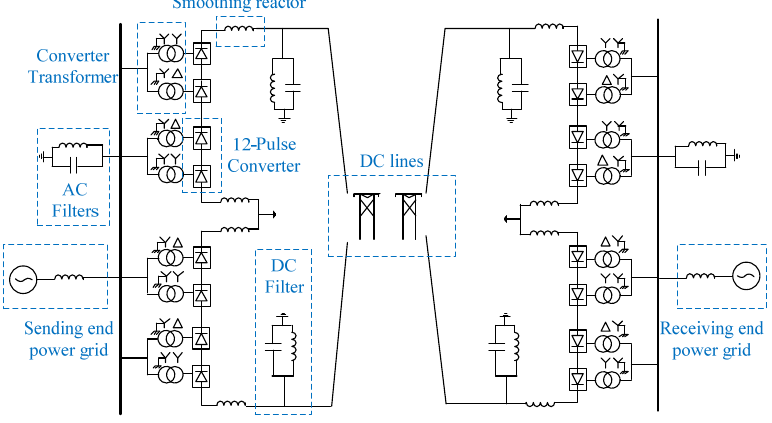
Figure 1. Basic Topology of UHVDC Transmission Project.